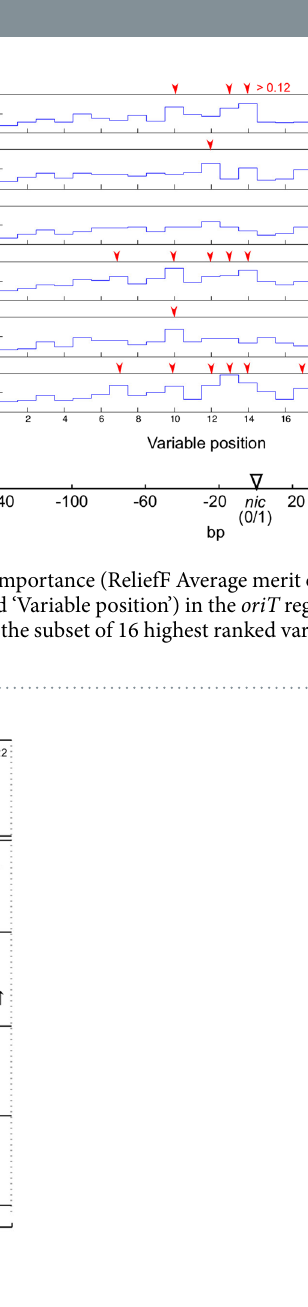
classification performance. Results showed that removal of any elements from the training dataset negatively affected the performance of the models. Although removal of the first nine elements (see Supp. Table S6) with a classification frequency below 0.2 led to improved results of cross validations ( Pre CV_64 increasing to 0.842 ± 0.008, Rec CV_64 to 0.790 ± 0.006 to Pre CV_64 to 0.988 ± 0.003 and Rec CV_64 to 0.979 ± 0.004 , P < 0.001), testing with the 140 element dataset showed a decrease in predictive performance ( Pre Test = 0.975 ± 0.001, Rec Test = 0.973 ± 0.001 to